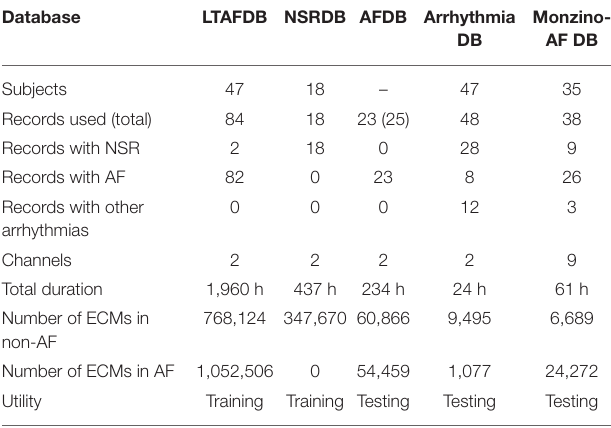
TABLE 1 | General description of databases used in the